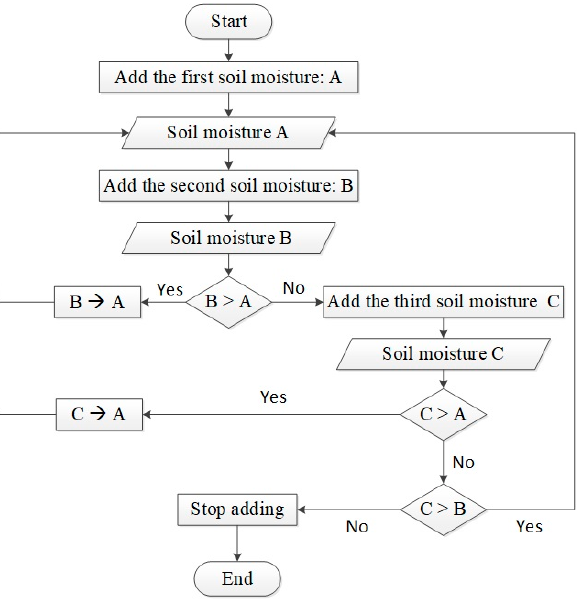
Figure 6. Flowchart of extracting soil moisture increased period.